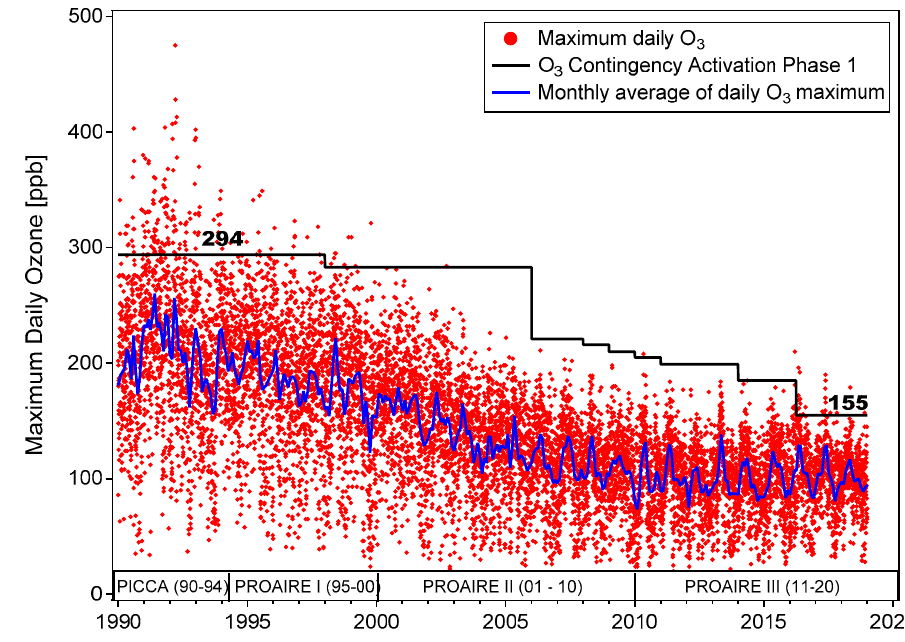
Figure 7. Daily maximum ozone concentrations (1990–2016) illustrating the changes on the threshold used to trigger environmental contingency.